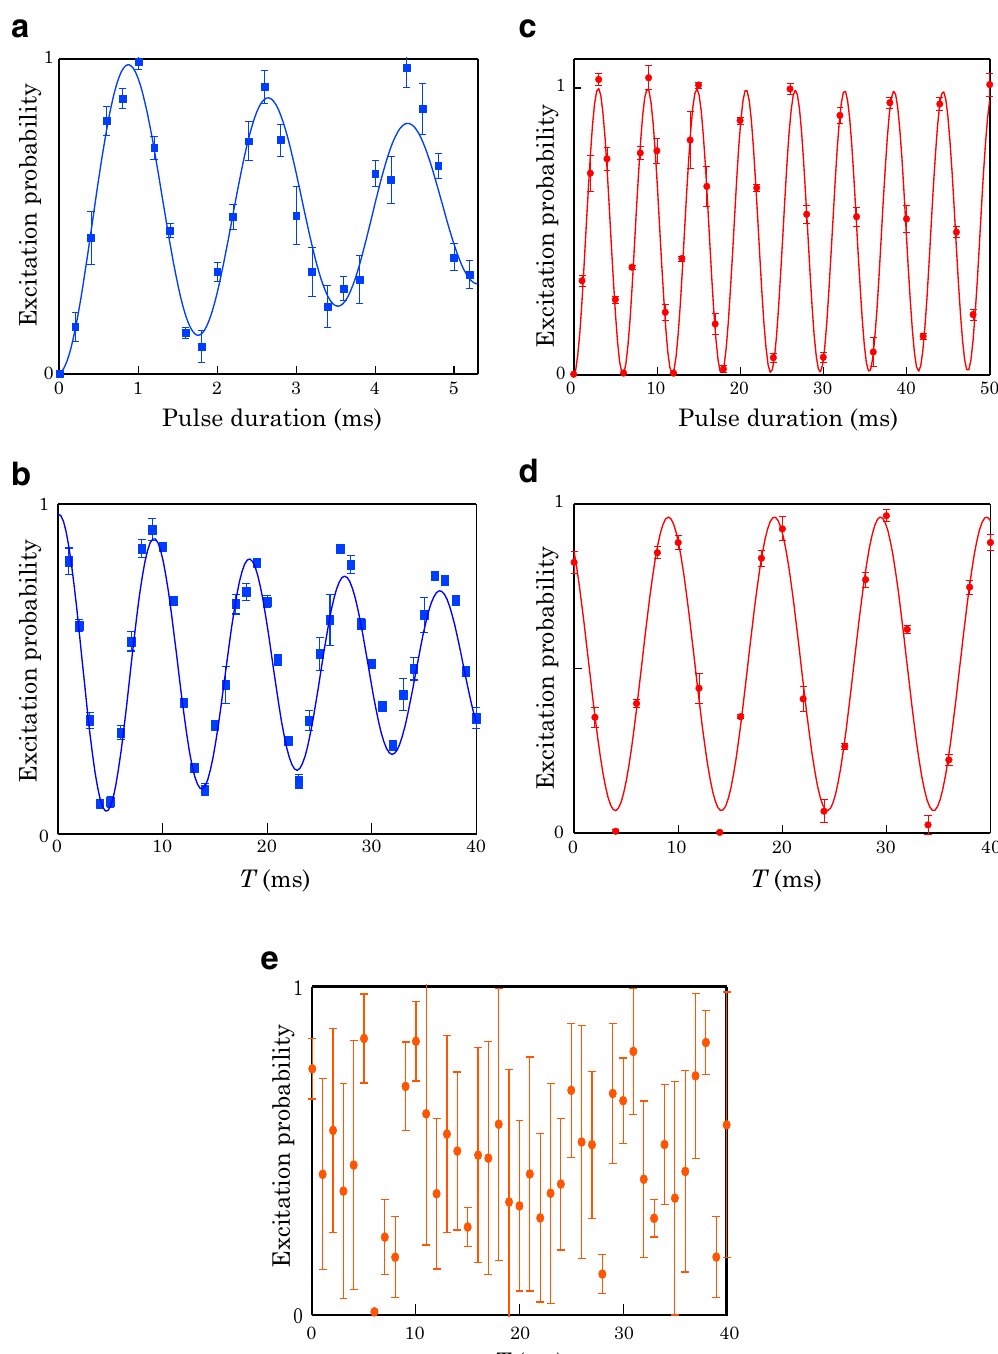
Figure 2. Rabi and Ramsey flops driven by D 1 -line/MW-RF fields. The lines are damped sinusoidal fit to the data. ( a ) D 1 -line Rabi flop. ( b ) D 1 -line Ramsey flop. ( c ) MW-RF Rabi flop. ( d ) MW-RF Ramsey flop. ( e ) Relative phase difference between the D 1 -line and MW-RF fields obtained with a Ramsey interferometry using the MW-RF and D 1 -line fields as the first and second π /2 pulses, respectively. The error bars reflect 1 σ statistical